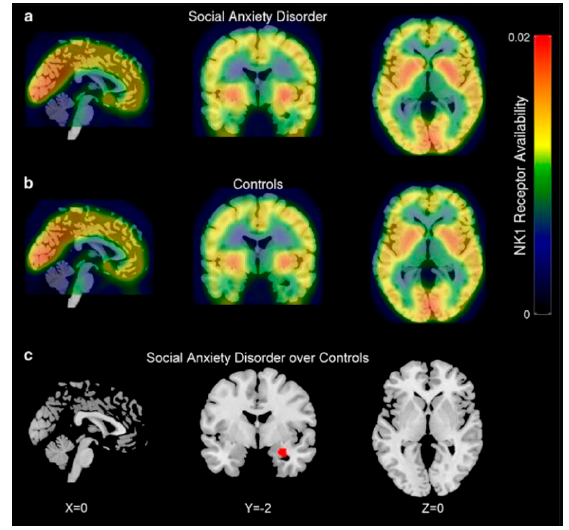
Figure 7. [ 11 C]GR205171 PET/MRI imaging of NK1R occupancy in social anxiety disorder patients ( a ) and healthy controls ( b ). Mean PET parametric scans (in colour) of radiotracer were overlaid on MRI images and compared between both groups. Patients with social anxiety disorder showed increased NK1 receptor availability in the right amygdala ( c ) [156].